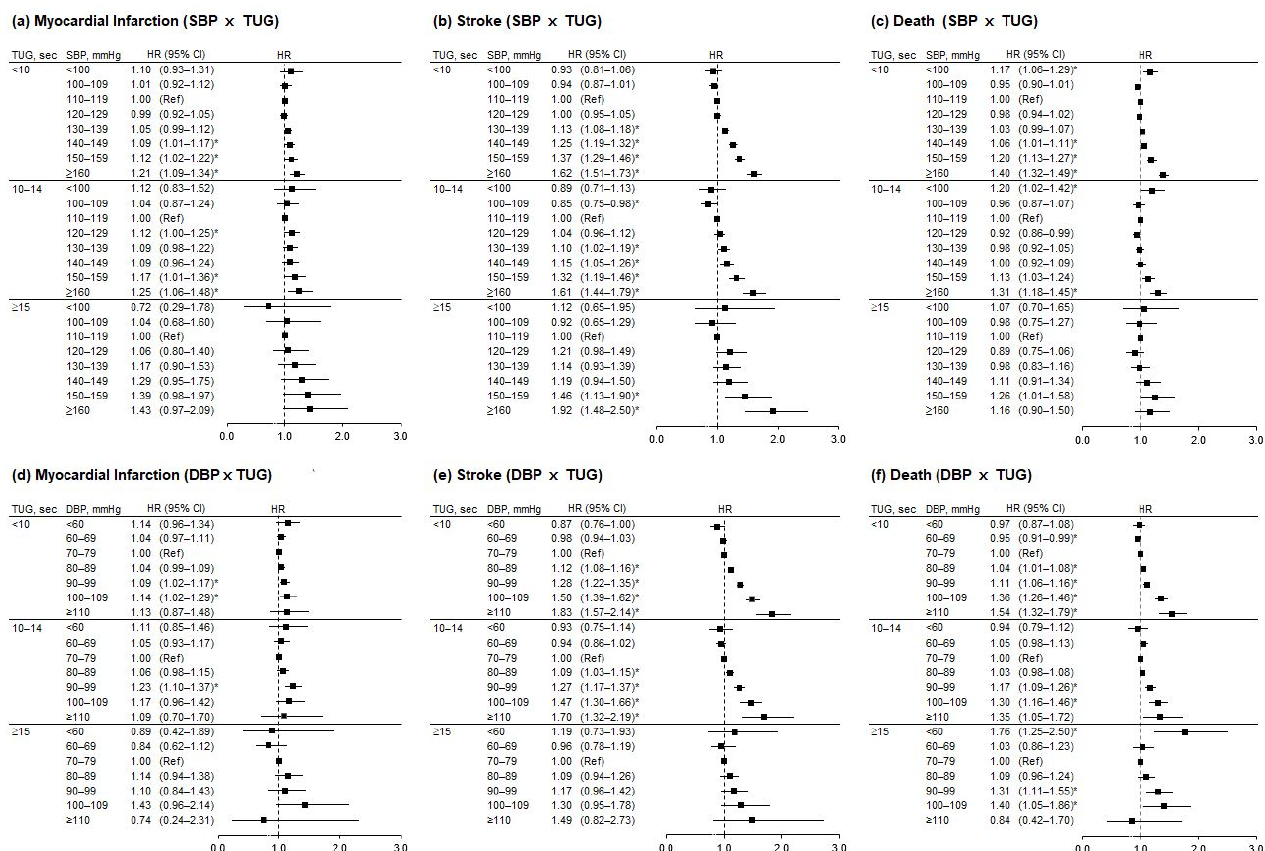
Figure 3. Hazard ratios for incidence of myocardial infarction, stroke, and death according to blood pressure, using 110–119 mmHg SBP or 70–79 mmHg DBP as a reference within each timed-up-and-go (TUG) group. Hazard ratios were adjusted for sex, BMI, smoking, hemoglobin level, alcohol drinking, regular exercise, income, antihypertensive drug use, diabetes, chronic kidney disease, and chronic pulmonary obstructive disease. Error bars indicate 95% confidence intervals. Asterisks indicate statistically significant values. TUG, timed-up-and-go test; SBP, systolic blood pressure; DBP, diastolic blood pressure; HR, hazard ratio; CI, confidence interval; Ref, reference.